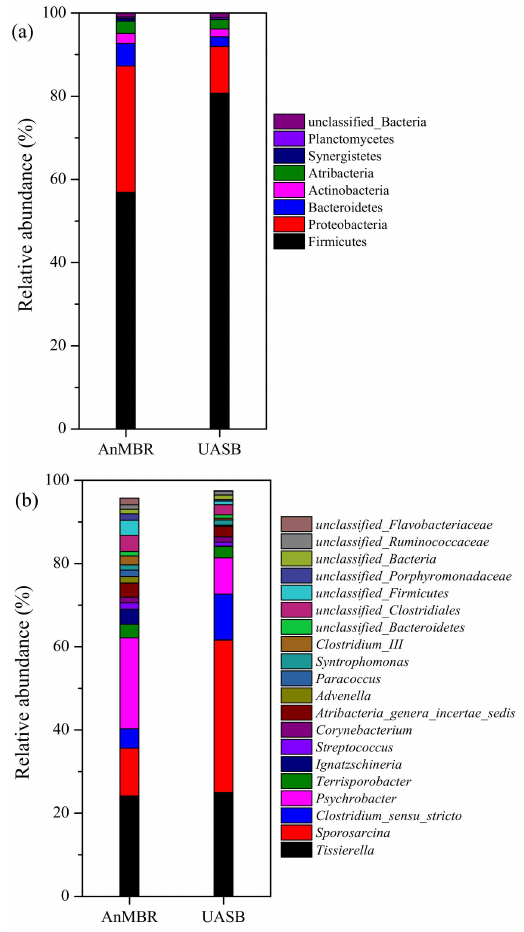
Figure 7. Bacterial communities in AnMBR and UASB. ( a ) phylum level, ( b ) genus